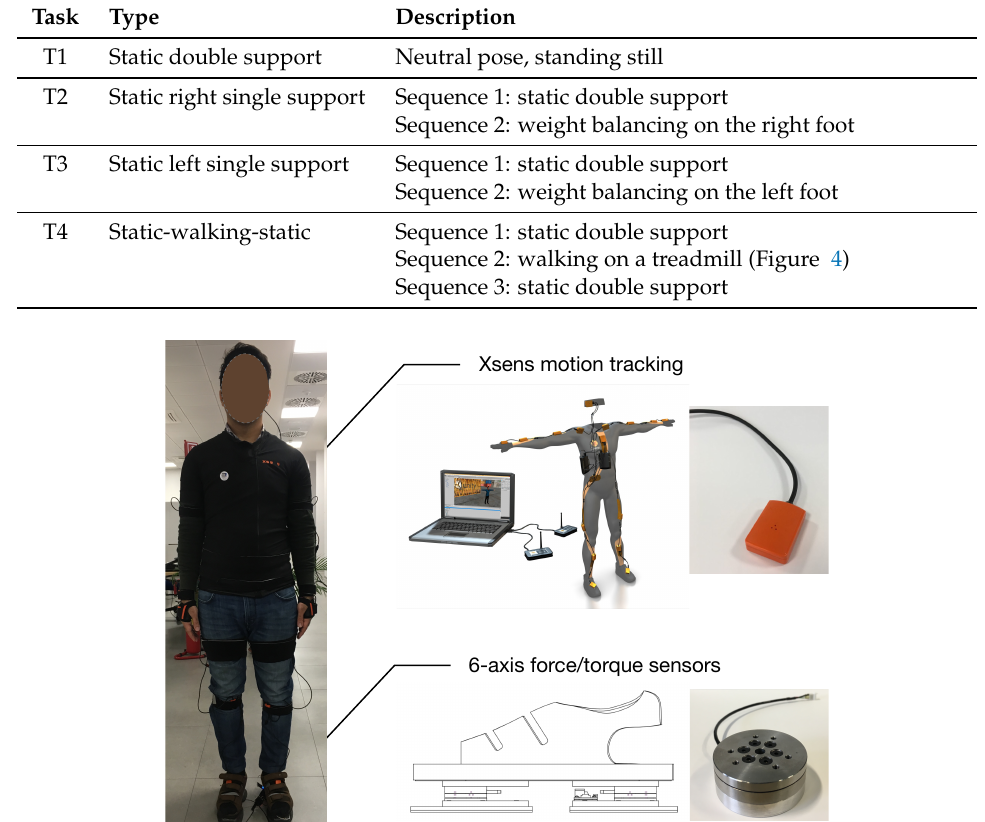
Table 1. Tasks performed for the estimation analysis.